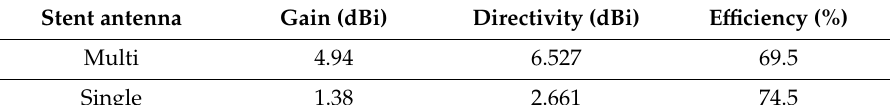
Table 2. The radiation characteristics of the stent antennas.